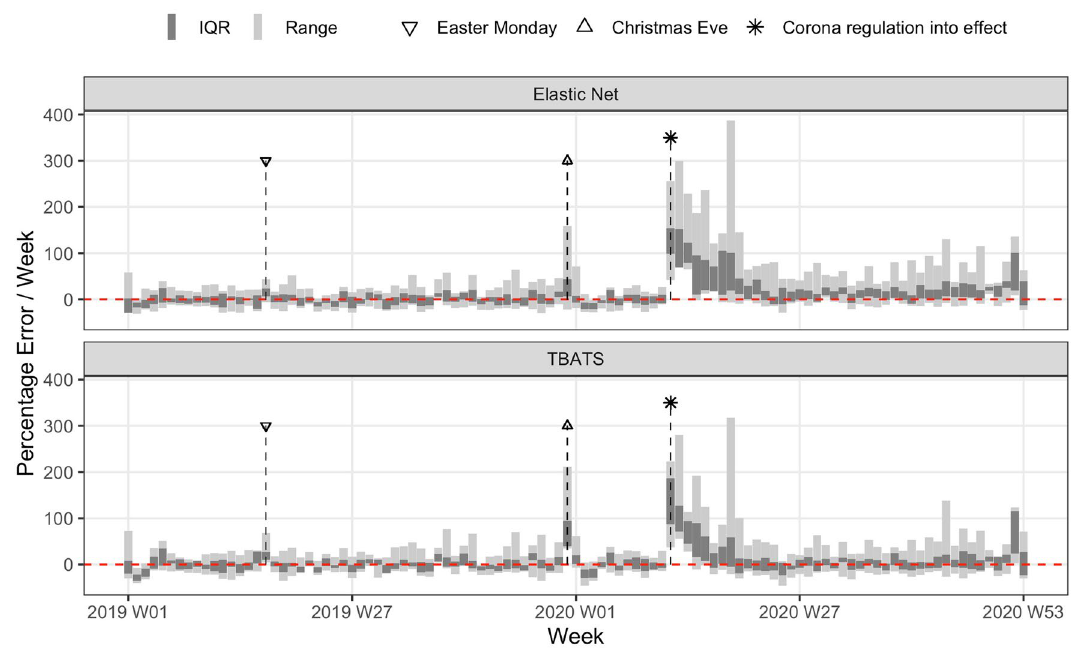
Figure 3. Variation of percentage error between study sites. TBATS = Exponential smoothing state space models with Box-Cox transformation, ARMA errors and trend and seasonal components, IQR = Interquartile range.